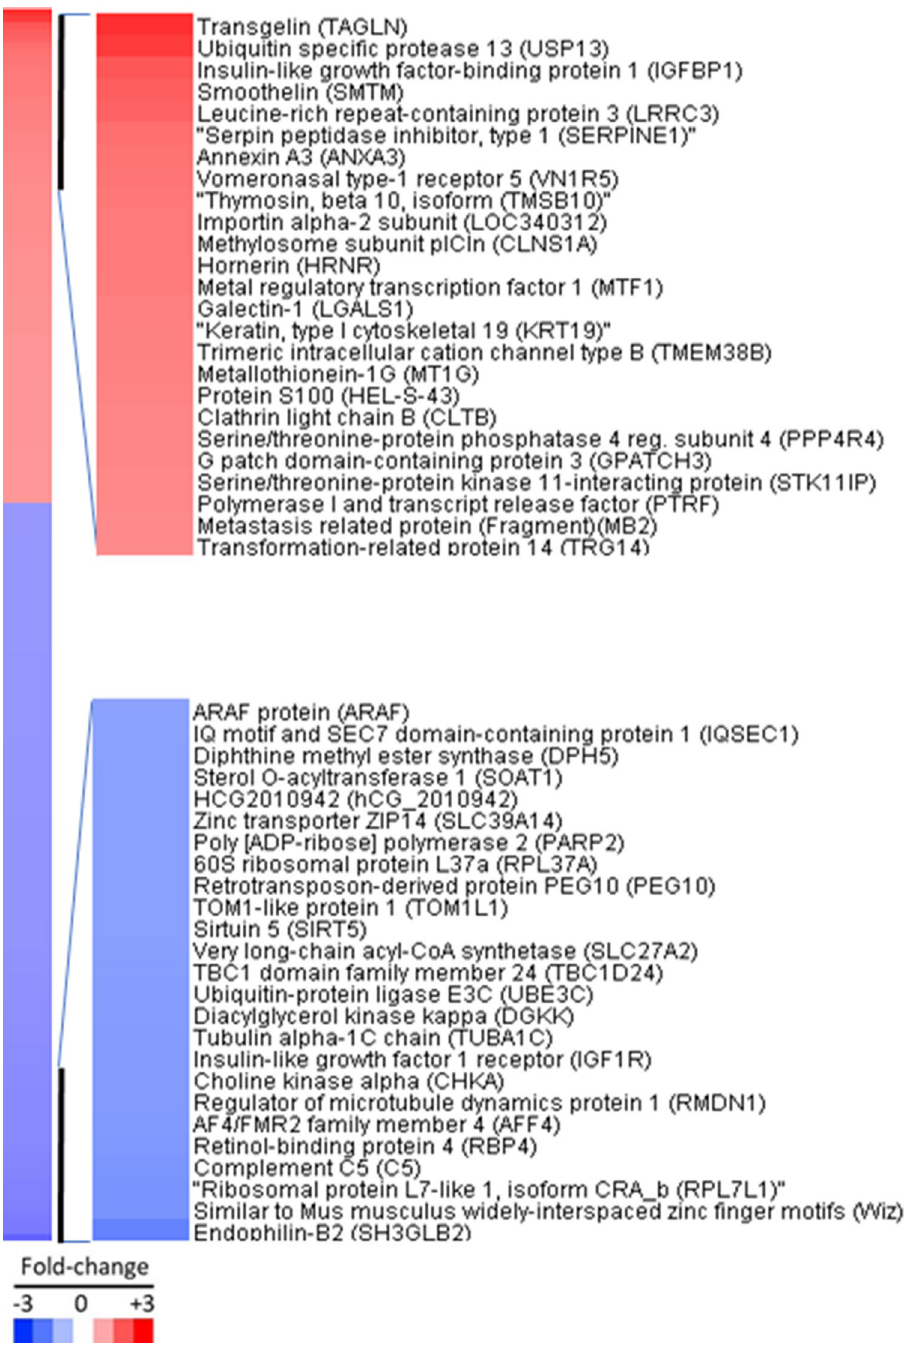
Figure 1. Heatmap of 182 differentially expressed proteins, with the top 25 up-regulated and 25down-regulated proteins detailed. 1.2-fold change and a P value < 0.05 (TreeView, version 1.6, https:// treev iew. softw are. infor mer. com/1.